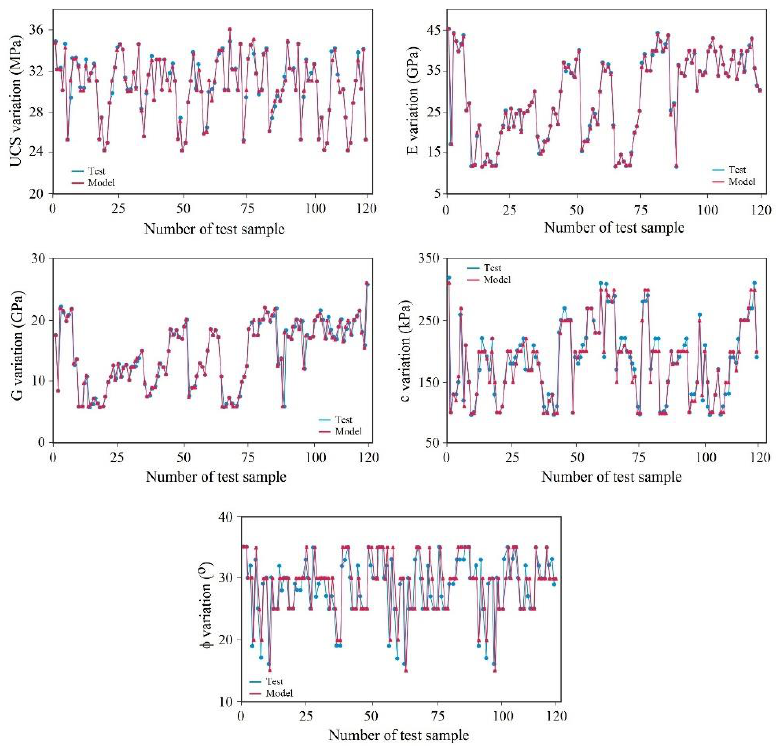
Figure 6. A comparison between the measured and predicted values based on the proposed method.